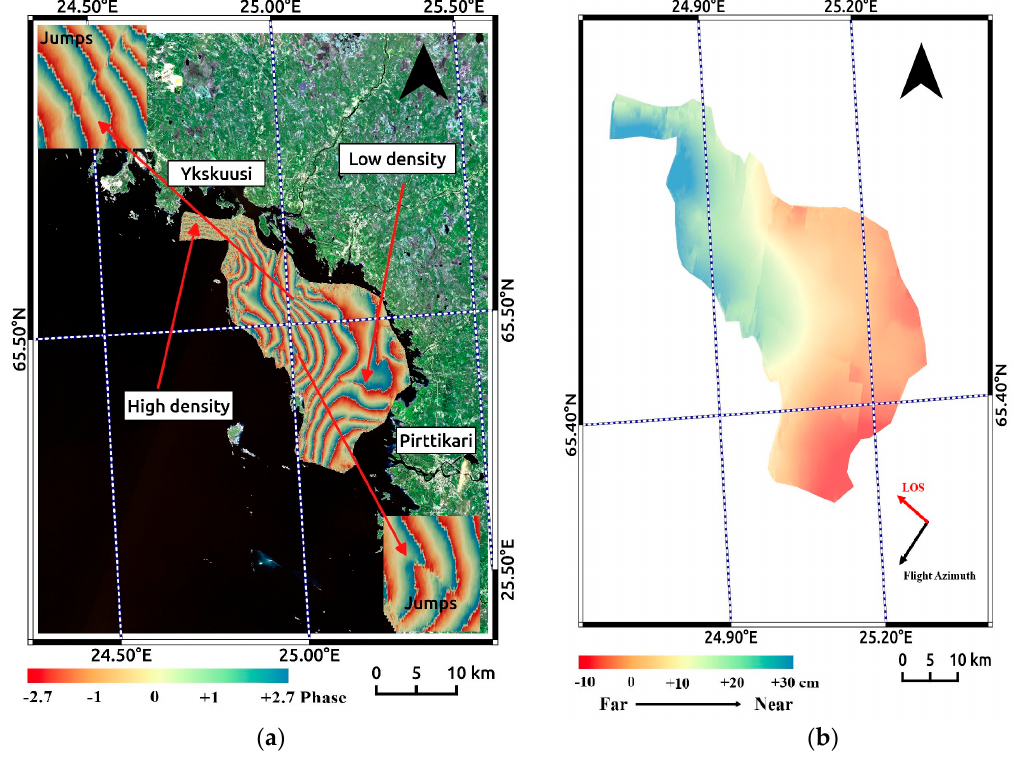
Figure 9. ( a ) The interferometric phase over 6 and 18 February 2015. We use the Sentinel-2 image as a background image. Green areas are land and islands, and black areas are water. ( b ) Displacement map from the unwrapped 6 and 18 February interferogram. “Near” means close to the satellite and “Far” means far away from the satellite.